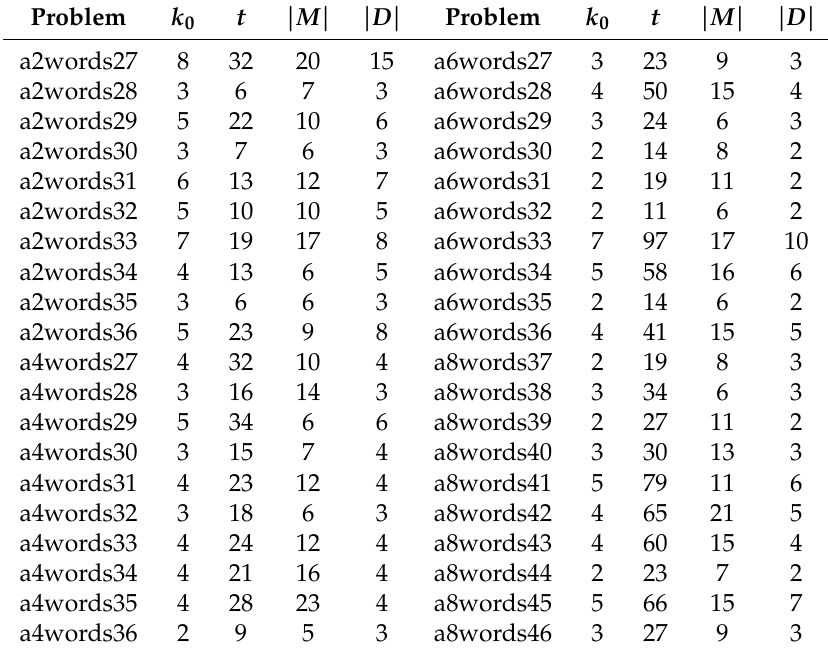
Table 1. Sizes of NFAs found by the answer set programming (ASP) solver ( k 0 —number of states, t —number of transitions, | M | —number of states in deterministic finite automaton (DFA) M , | D | —number of states in minimal DFA D compatible with sample